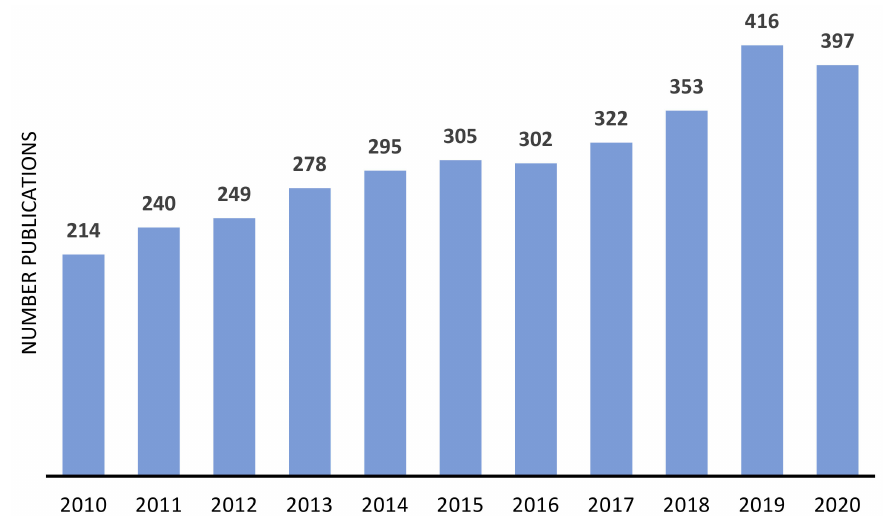
Figure 5. Approximate annual number of publications on immobilized metal complexes on zeo- lites and other similar materials since 2010. Source: ISI Web of Knowledge, 29 September 2021. Search terms: “immobilized metal complexes” OR “anchored metal complexes” OR “heterogenized metal complexes”.